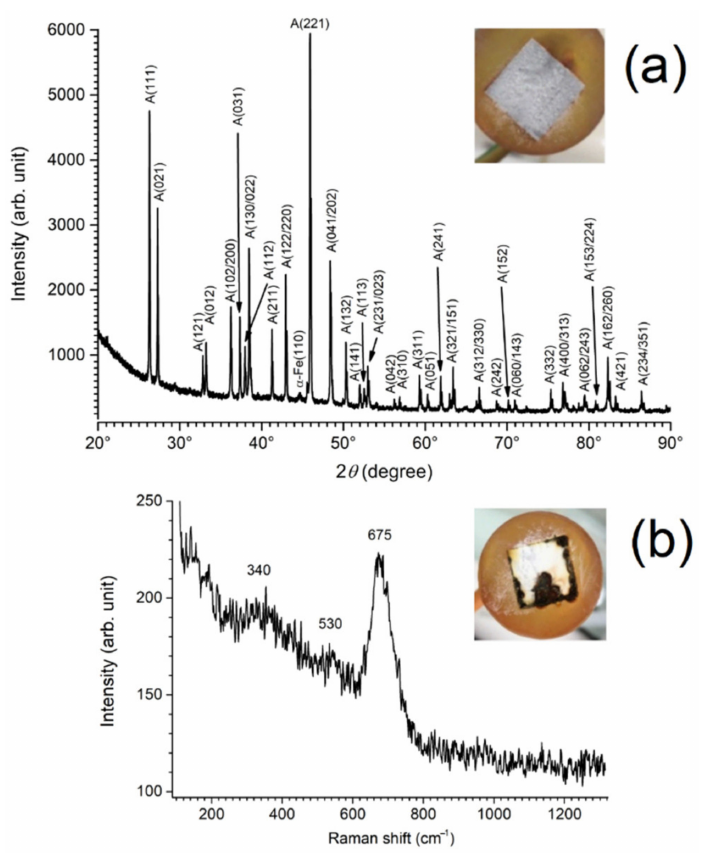
Figure 13. XRD analysis of a bare steel electrode connected to a Zn-15wt.% Al-coated electrode ( a ) and Raman spectrum obtained during the analysis of the bare steel sample connected to the Zn-2-coated electrode ( b ). In both ( a , b ), the additional image displays the surface of the paired steel